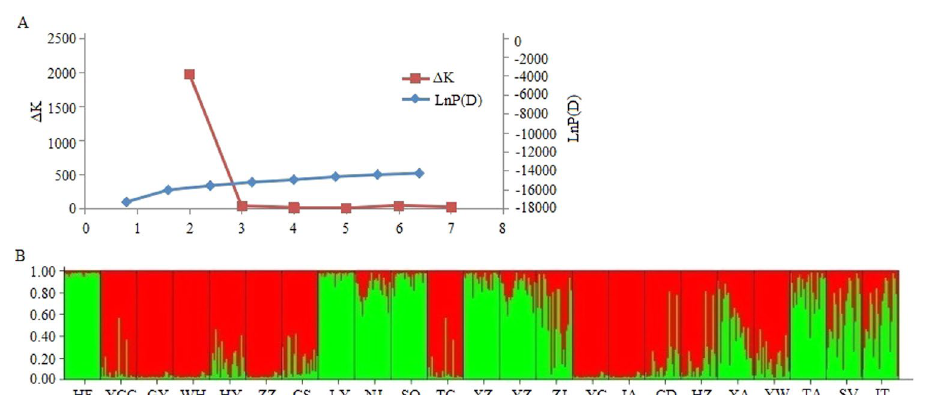
Figure 2. Cluster analysis by STRUCTURE for 23 populations of C. ciliata . ( A ) Inference of the number of genetic clusters (K) for C. ciliata populations. ( B ) Proportion of genome of each individual assigned to each of the two clusters. Each individual is represented by a vertical